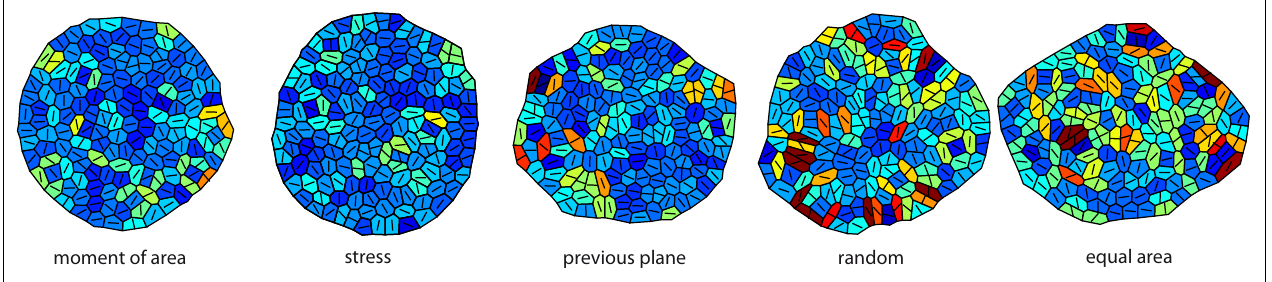
growth and the anisotropy of the overall tissue shape increases from left to right accompanied by individual cell shape being less circular. Data shown are tissues comprising about 150 cells grown at a feedback of 14.